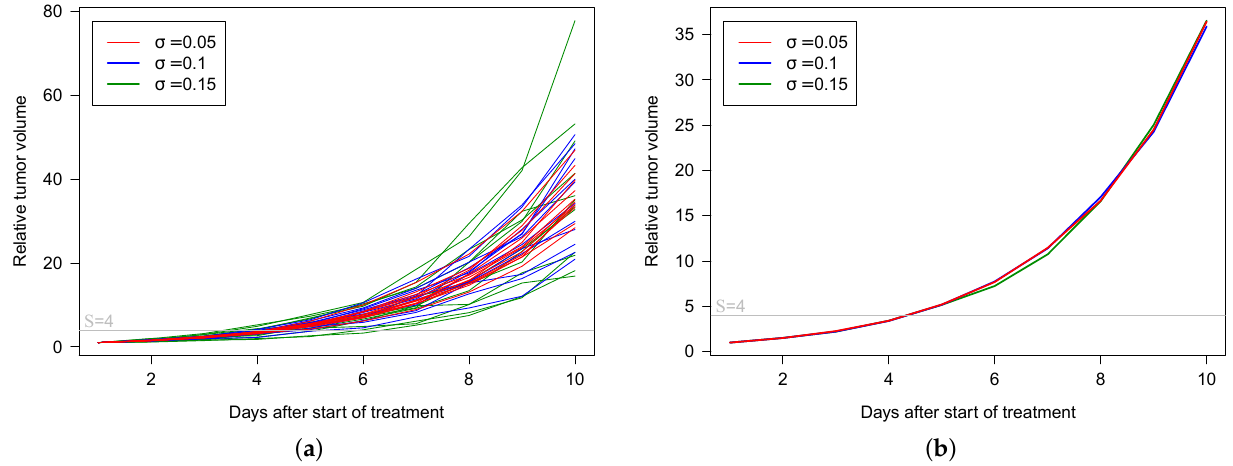
Figure 2. ( a ) Simulated sample paths of the lognormal diffusion process with m = 0.4 and σ = 0.05, 0.1, 0.15. ( b ) Sample mean functions from the simulated sample